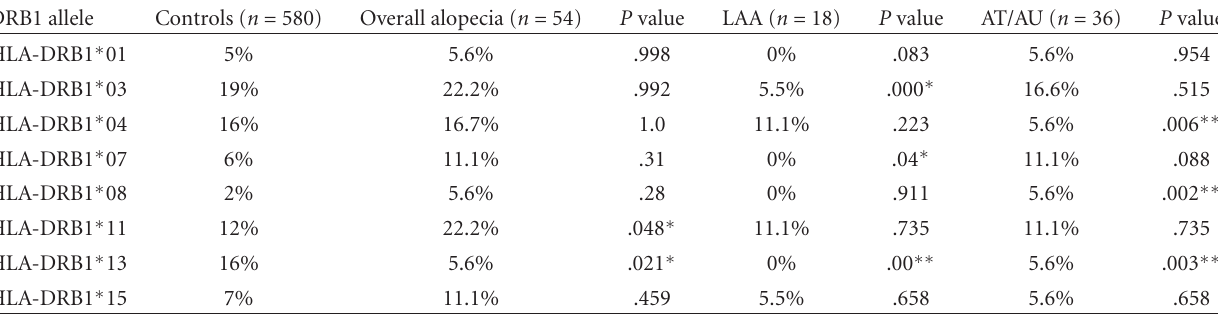
Table 4: Frequencies of selected HLA-DRB1 alleles in alopecia patients compared to controls using Chi square test. DRB1 allele